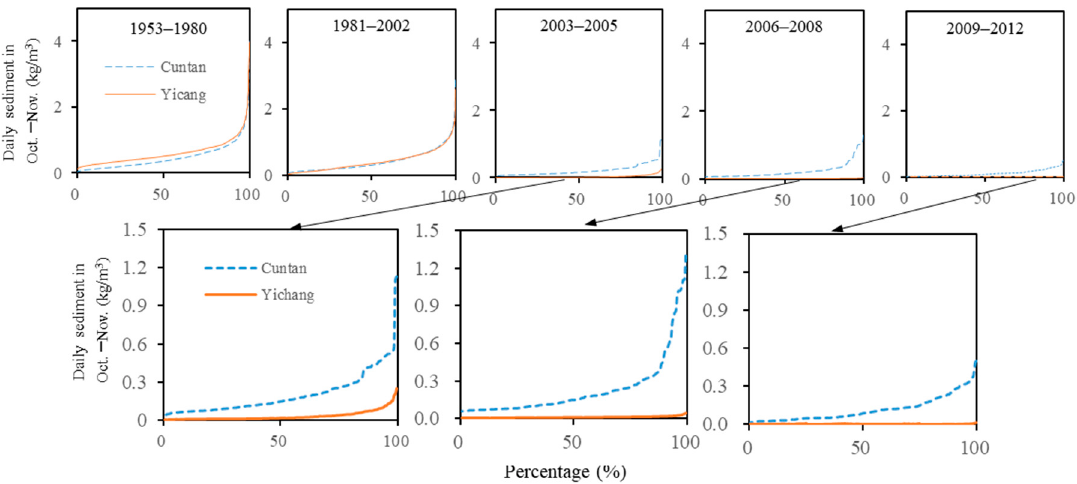
Figure 5. Frequency distributions of the daily sediment concentration in October–November during different periods.